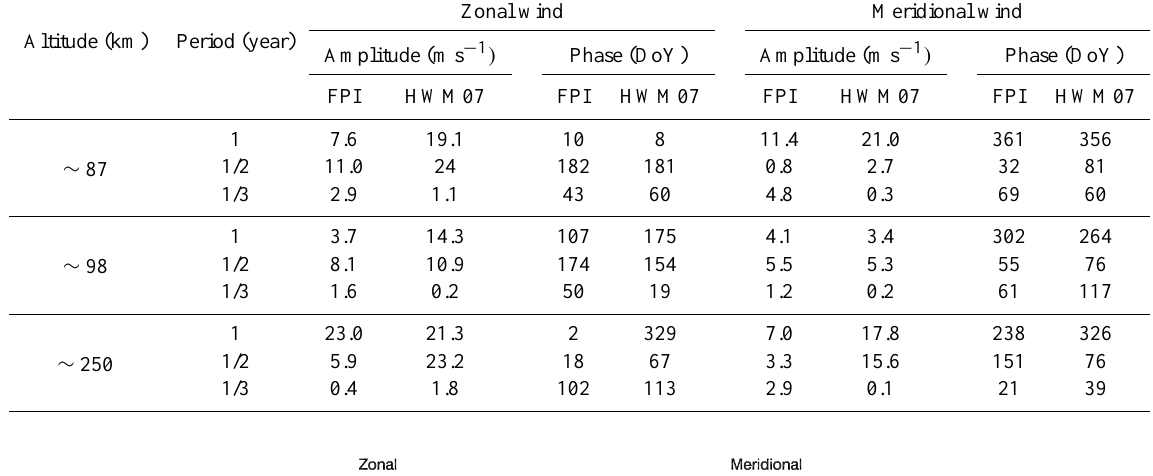
Table 1. Amplitudes and phases of annual, semiannual, and terannual variations for FPI and HWM07 winds (DoY = day of year).